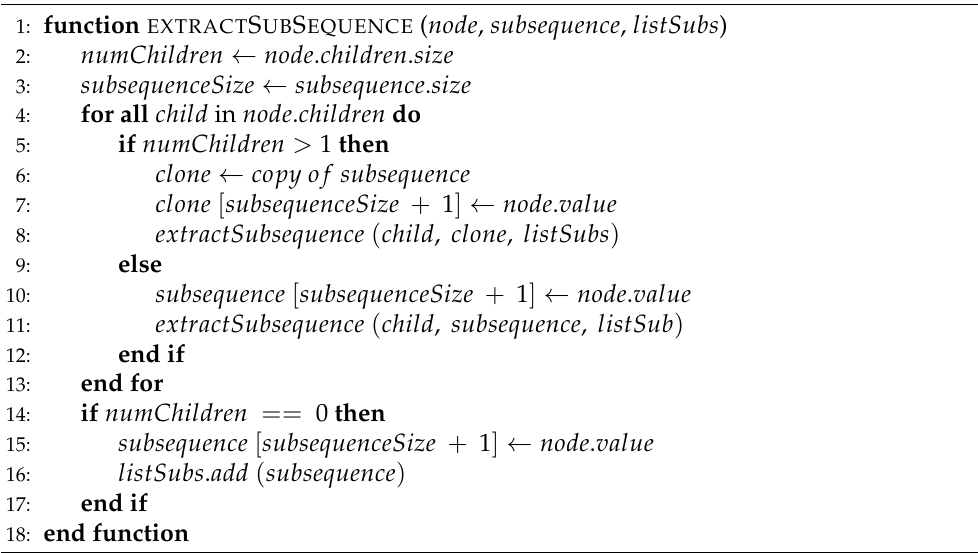
Algorithm 4 Extract Sub-sequence from Tree